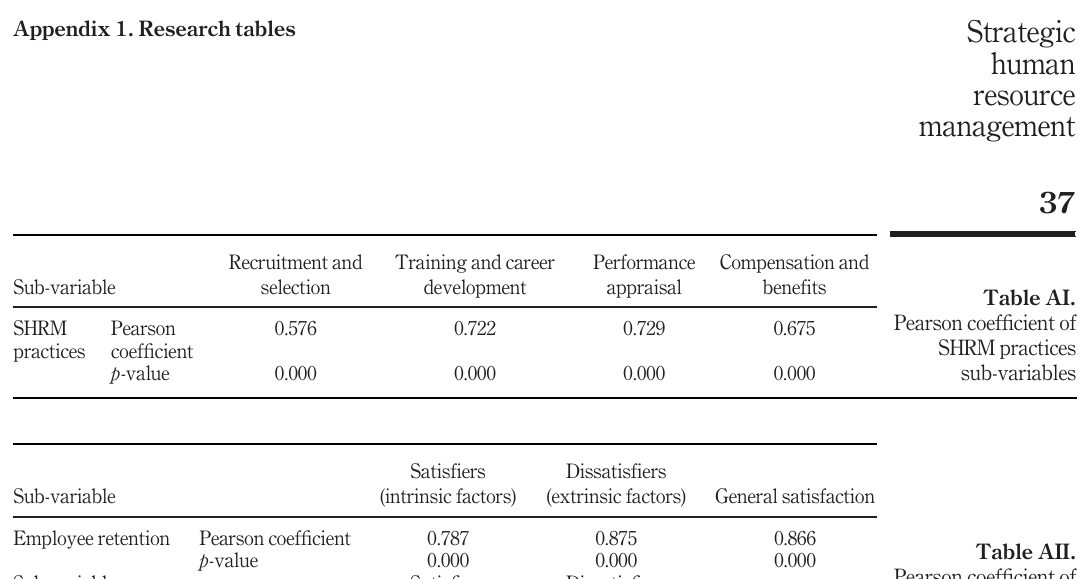
Table AII. Pearson coef fi cient of